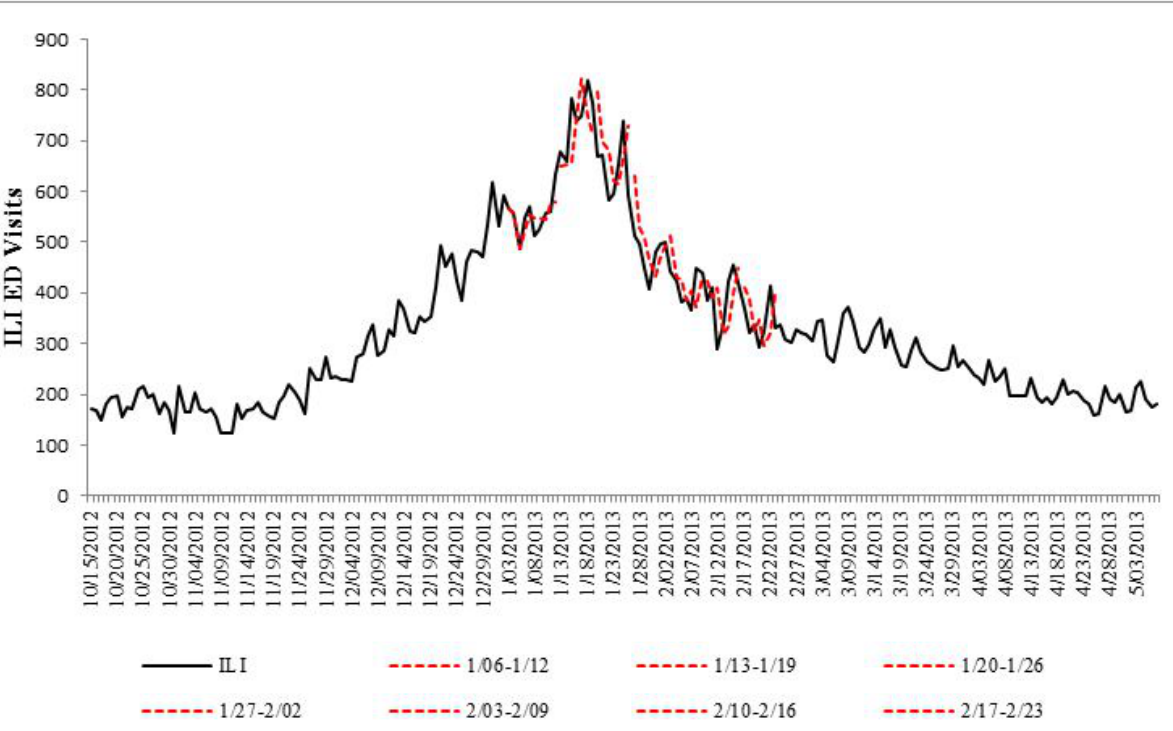
Figure 3. Predicted ILI-ED visits in red using the Infection tweets model (Model